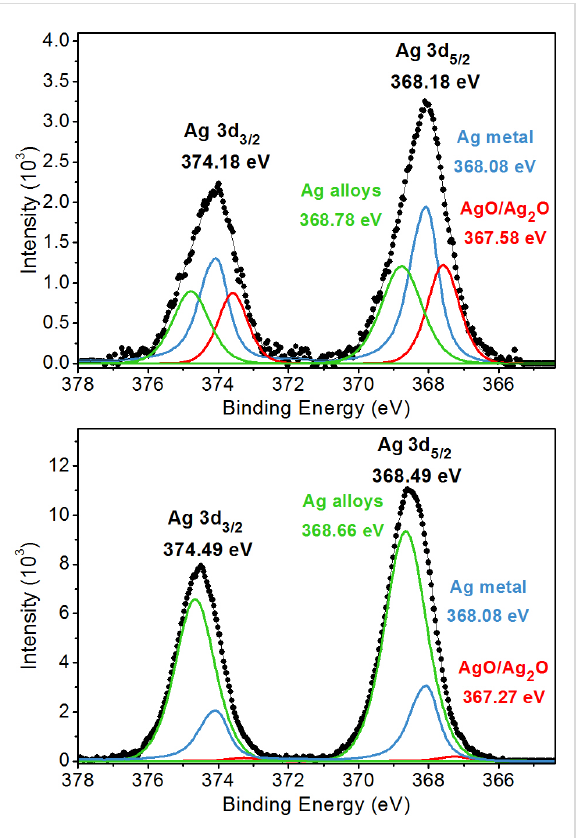
Figure 3: XPS Ag 3d 1/2 and Ag 3d 5/2 spectra of freshly prepared Ag–TiO 2 core–shell structures (top) and after annealing at 150 °C for 12 h (bottom).